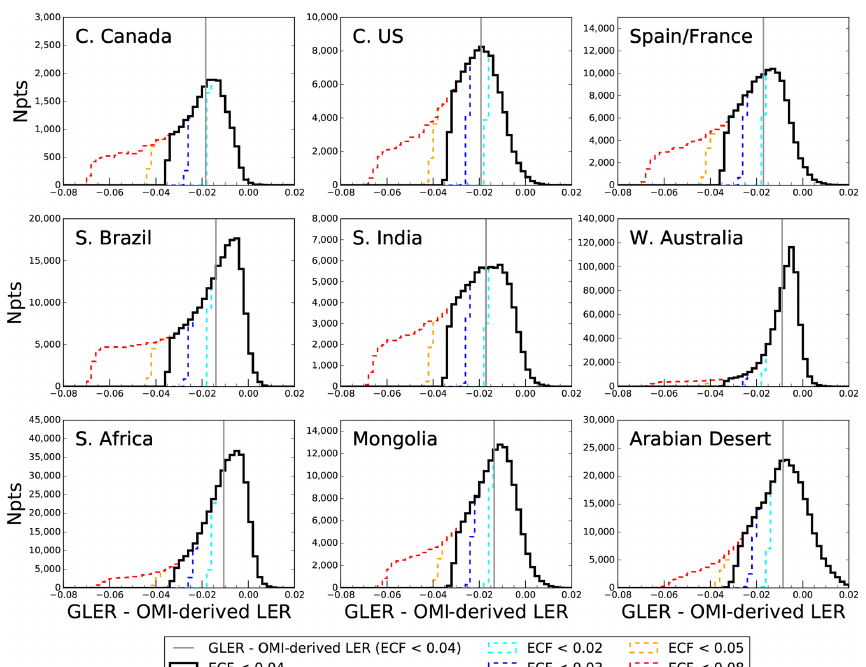
Figure C1. Histograms showing the distribution of the difference between GLER and OMI-derived LER for various O 2 –O 2 ECF screenings across different geographical regions in 2006. While no cloud screening was performed, aerosols were removed and OMI scenes with land fraction < 99% were not included. The vertical grey line represents the mean of the difference between GLER and OMI-derived LER for the various regions. The dark black line representing ECF < 0 . 04 was the cloud screen implemented in the evaluation of GLER for this paper.